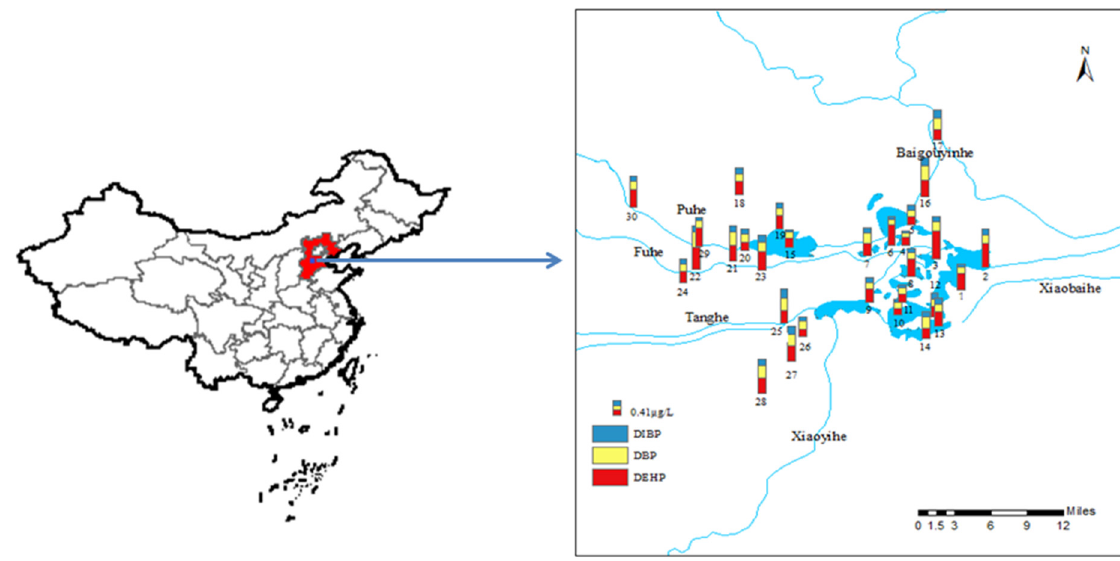
Figure 1. Location of sampling sites and PAEs concentration in Baiyangdian Lake.